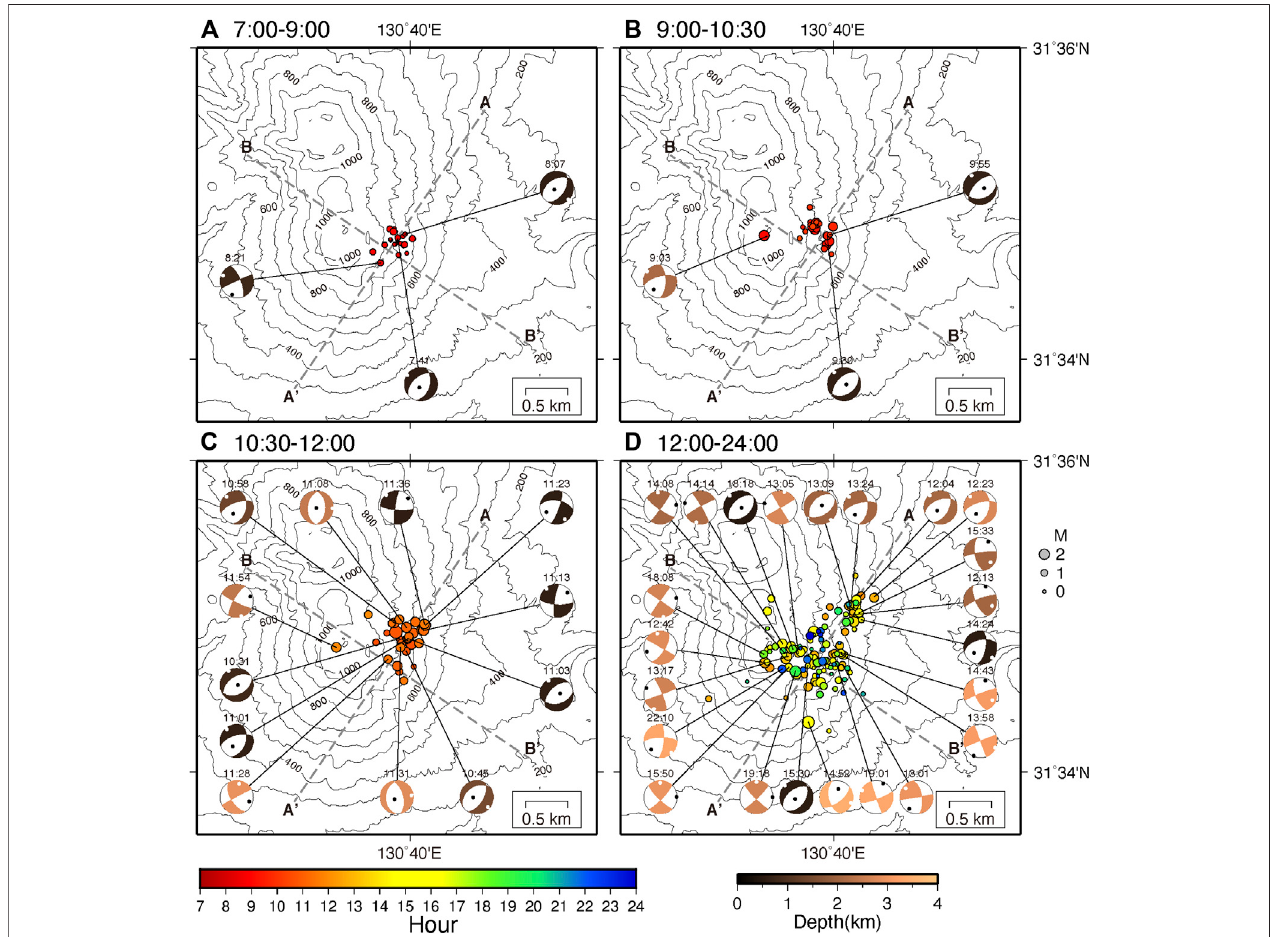
FIGURE 8 | Epicenter distributions of the VT earthquakes (circles). The colors of the circles indicate the occurrence time same as Figure 7 . Some of focal mechanisms (beach balls) areshown alongwith their epicenters. Thecolorsofthe beach ballsindicate focal depths. The occurrence time ofthe focal mechanism isalso shown along with corresponding beach ball. Contours are provided every 100 m. (A) Period from 7:00 to 9:00 JST. (B) Period from 9:00 to 10:30 JST. (C) Period from 10:30 to 12:00 JST. (D) Period from 12:00 to 24:00 JST.